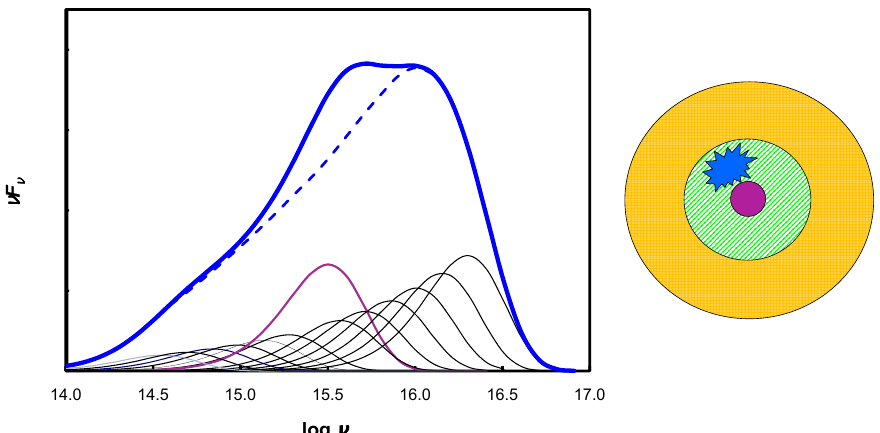
Fig. 5. Panel (a). The theoretical spectrum arising from an accretion flow. The indi- vidual Planck curves (see the text) are shown to scale. The dashed line is the integrated spectrum from a uniform disk. The thick line shows the spectrum when the temperature of the zone producing the flux around 1 Rydberg (the thicker Planck curve) increases by 20%. Panel (b). Cartoon of variability within an